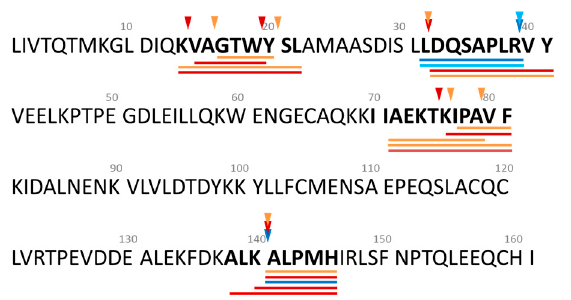
Figure 8. Primary sequence of bovine β -lactoglobulin showing specific cleavage sites and the peptides identified in whey protein concentrate hydrolysed using FlavorPro Whey (FPW) under pH-controlled ( ), non pH-controlled ( ) conditions and Debitrase (DBT) under pH-controlled ( ) and non pH- controlled ( ) conditions. Peptide sequences underlined in different colours indicate the peptides identified in the samples described above.